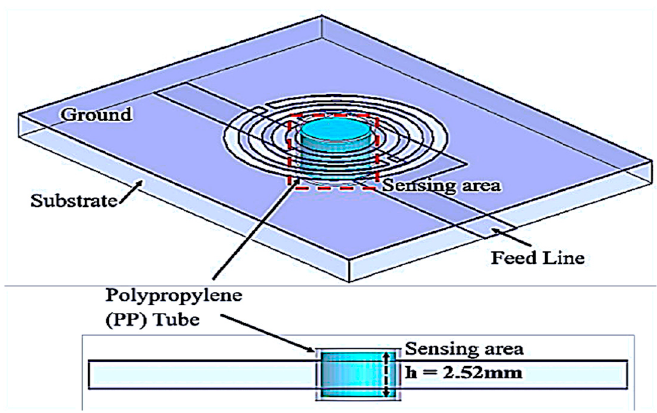
Figure 8. PP tube loaded into the substrate for 7.92 μ L at a time.